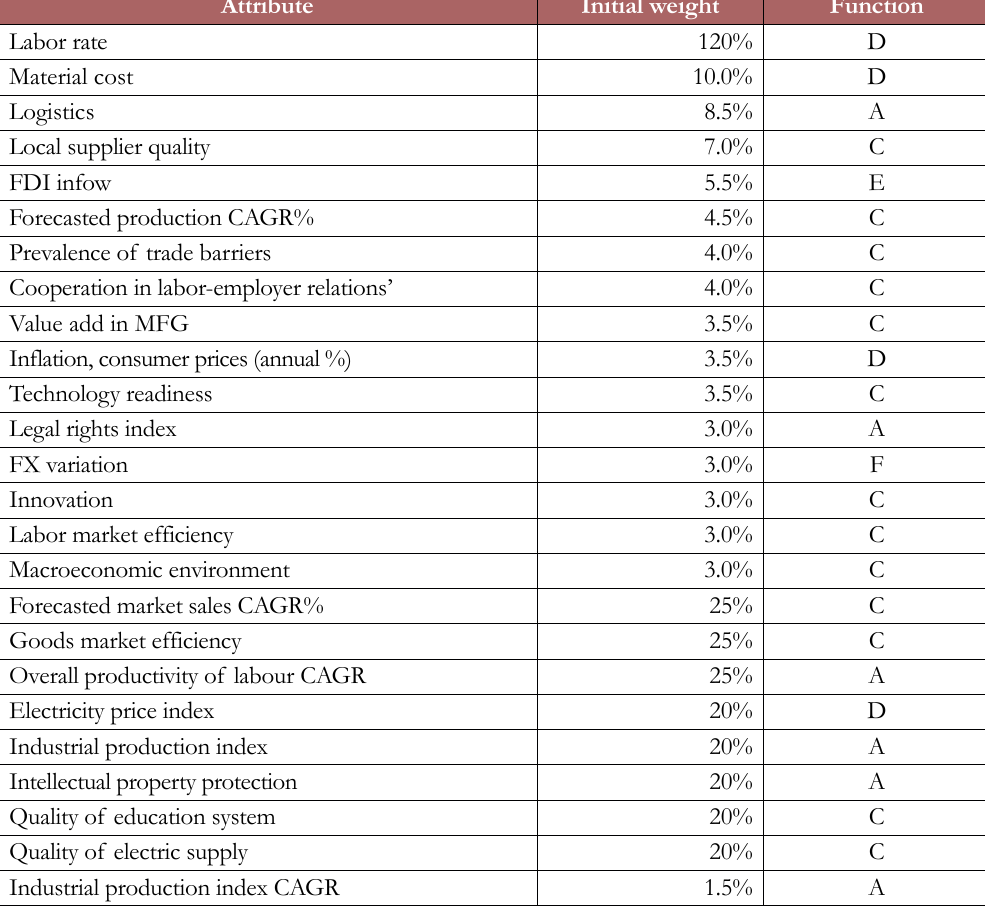
Table 1. Baseline factors, weights, and